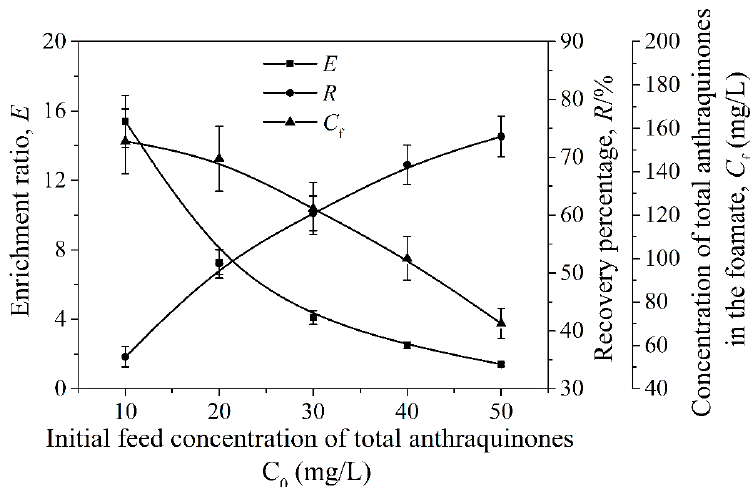
Figure 4. Effects of initial feed concentration of total anthraquinones in the feed solution on enrichment ratio and recovery percentage of total anthraquinones and their concentration in the foamate.